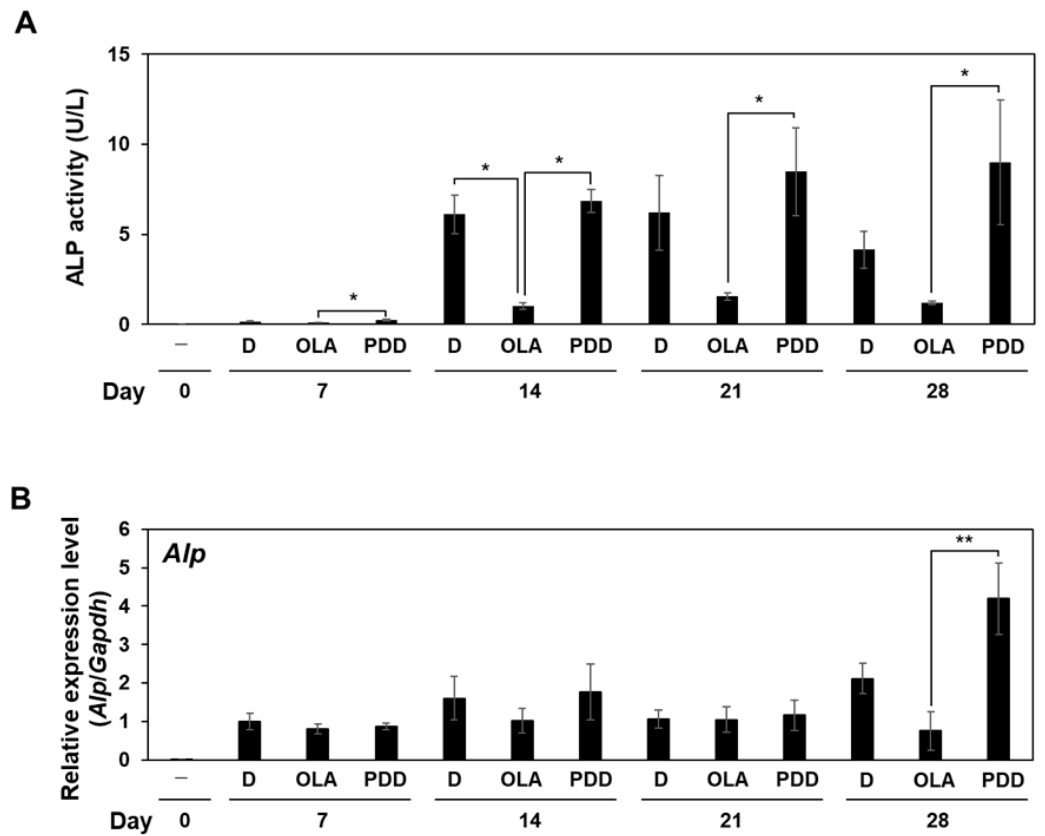
Figure 2. Effects of olaparib and PDD00017273 on ALP activity and mRNA expression of Alp during osteoblast differentiation. ( A ) ALP activity in olaparib- and PDD00017273-treated MC3T3-E1 cells. MC3T3-E1 cells were treated with DMSO, 1 µ M olaparib, or 1 µ M PDD00017273 after incubation in differentiation medium for 0–28 days. ALP activity was measured at specified time points. ( B ) Levels of Alp mRNA expression determined by qRT-PCR and normalized to the mRNA expression in DMSO- treated cells on day 7 after incubation in differentiation medium. Alp expression was increased in PDD00017273-treated cells compared with olaparib-treated cells at 28 days after incubation with differentiation medium. To obtain these data, at least three independent experiments were performed. D, DMSO; OLA, 1 µ M olaparib; PDD, 1 µ M PDD00017273. Data are shown as mean ± SE. * p < 0.05, ** p < 0.01 (Tukey’s